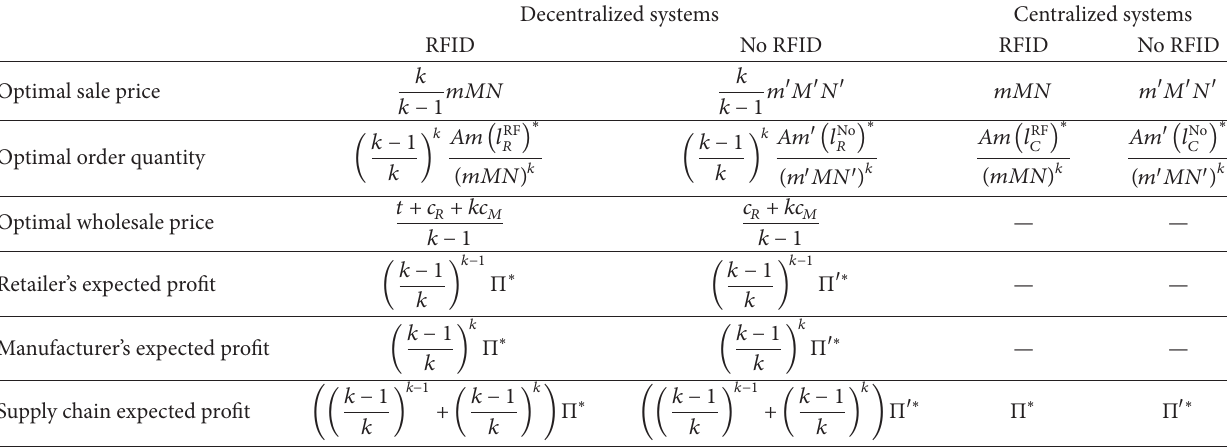
Table 2: Summary of optimal decisions and profits in different scenarios under CVaR